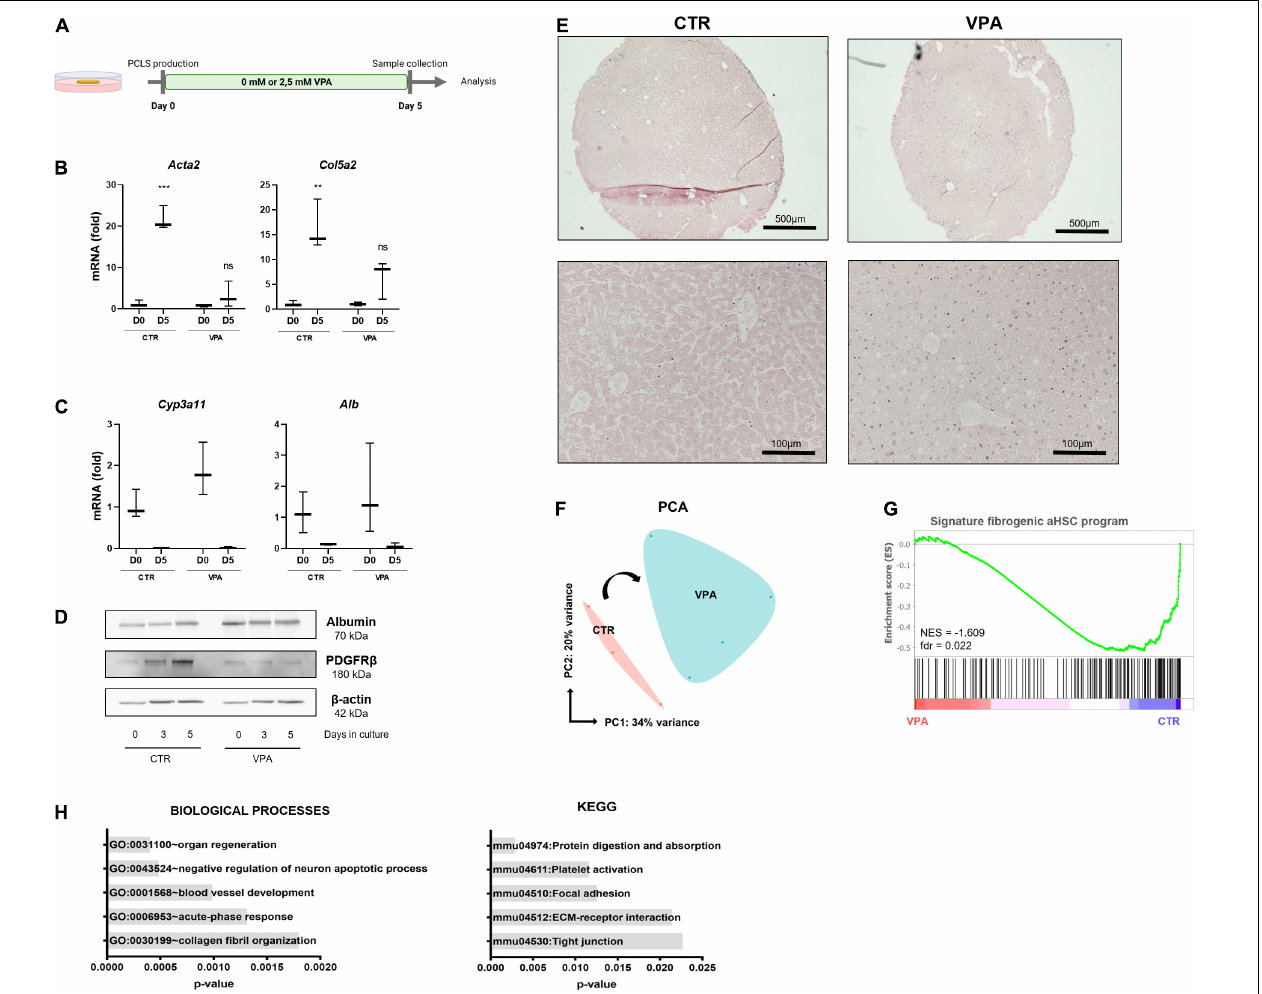
FIGURE 2 | Valproic acid improves PCLS culture conditions and represses the pro-fibrotic signature. (A) PCLS were cultured in the absence (control) or presence of VPA (2.5 mM VPA) for 5 days. (B) VPA supplementation reduces HSC activation ( n = 3) but (C) does not affect hepatocyte marker mRNA levels ( n = 3). (D) PDGFR β protein expression was reduced, and albumin protein expression was slightly higher over time in the presence of VPA. (E) H&E staining on day 5 shows better preservation of liver histology when PCLS cultures are VPA supplemented. (F) PCA plot of PCLS cultures with/without VPA shows division of both conditions over PC1 ( n = 4). (G) GSEA analysis shows that the fibrogenic aHSC gene signature is significantly enriched in the standard culture conditions but not in VPA supplemented cultures. (H) GO analysis of biological processes (left) and KEGG analysis (right) of downregulated genes in PCLS cultured with VPA. **p ≤ 0.01, ***p ≤